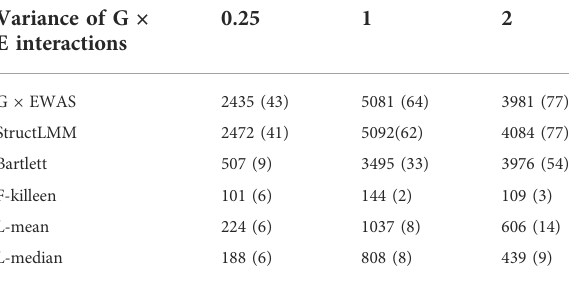
TABLE 2 Signi fi cant G × E interaction single nucleotide polymorphisms (SNPs) detected on simulated data using the proposed G × EWAS method and the fi ve approaches, StructLMM, Bartlett, F-Killeen, L-mean and L-median under different variance of G × E interactions. The SNP numbers overlapping with simulated genotype – environment interaction quantitative trait locus (306) are in